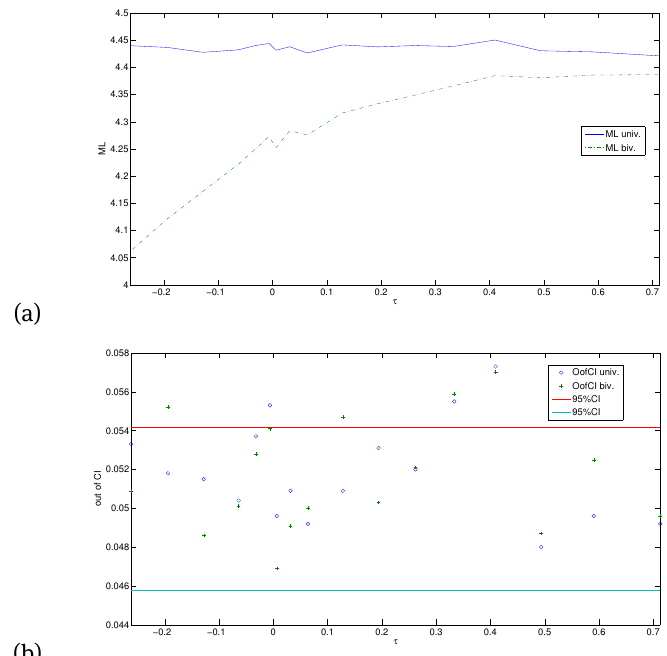
α N . Panel (b) gives the proportion of ob-